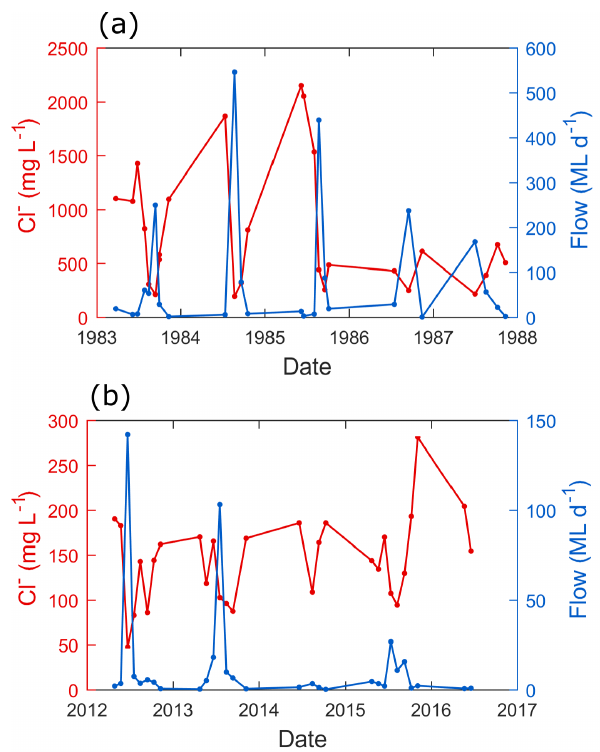
Figure 13. Stream water chloride concentration and flow rate over selected periods for (a) Gawler River and (b) Brownhill Creek. The axes in (a) and (b) have a different